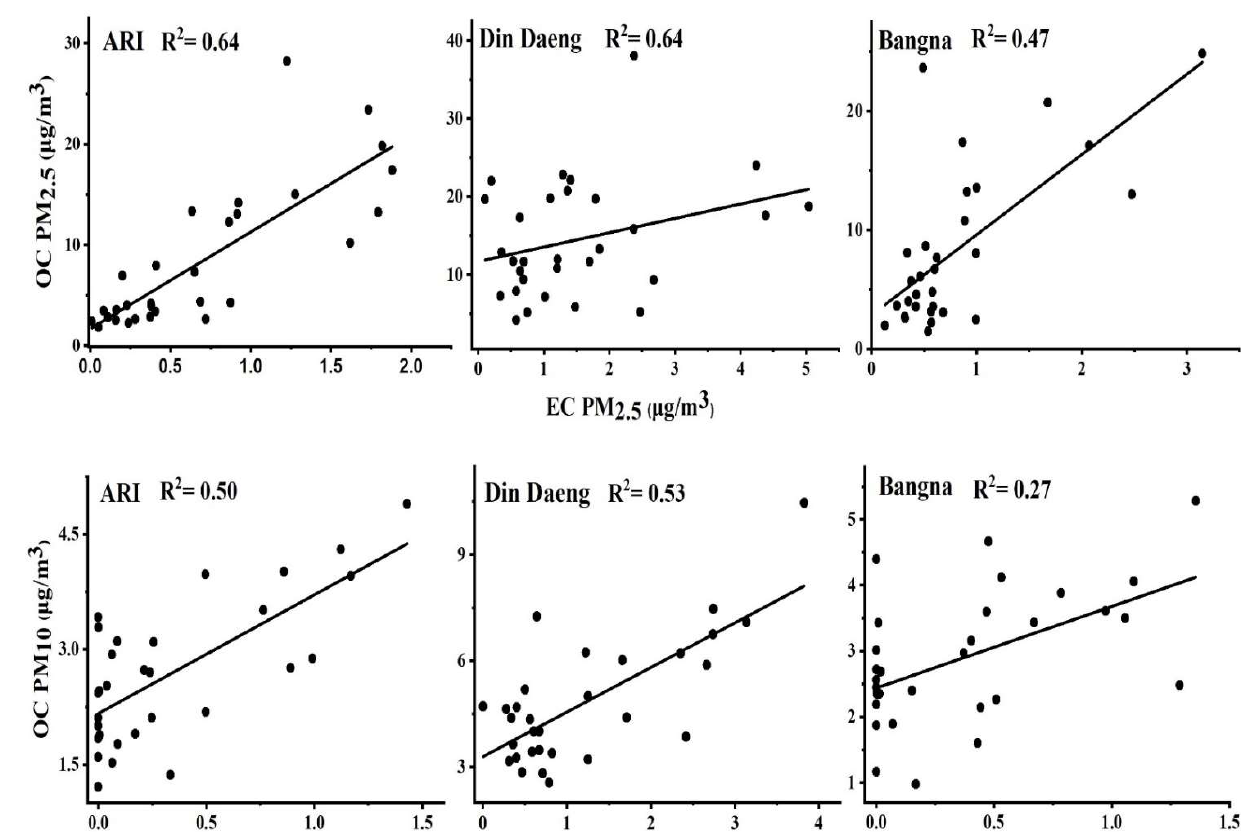
Figure 4. Scatter plots for OC and EC: PM 2.5 and PM 10 for Ari, Din Daeng, and Bangna, Bangkok, Thailand.